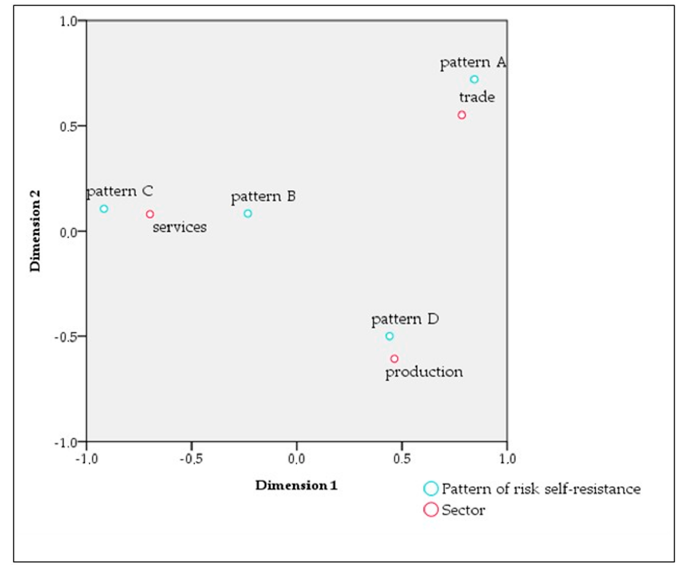
Figure 4. Perceptual map (correspondence analysis).